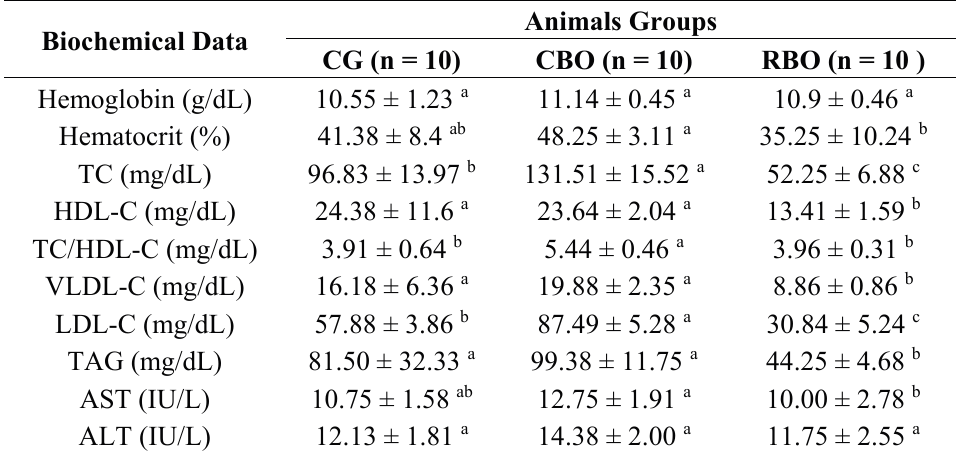
Table 3. Lipid and haematological profile of Wistar rats fed with diets added of soybean oil or refined or crude buriti oil. Biochemical